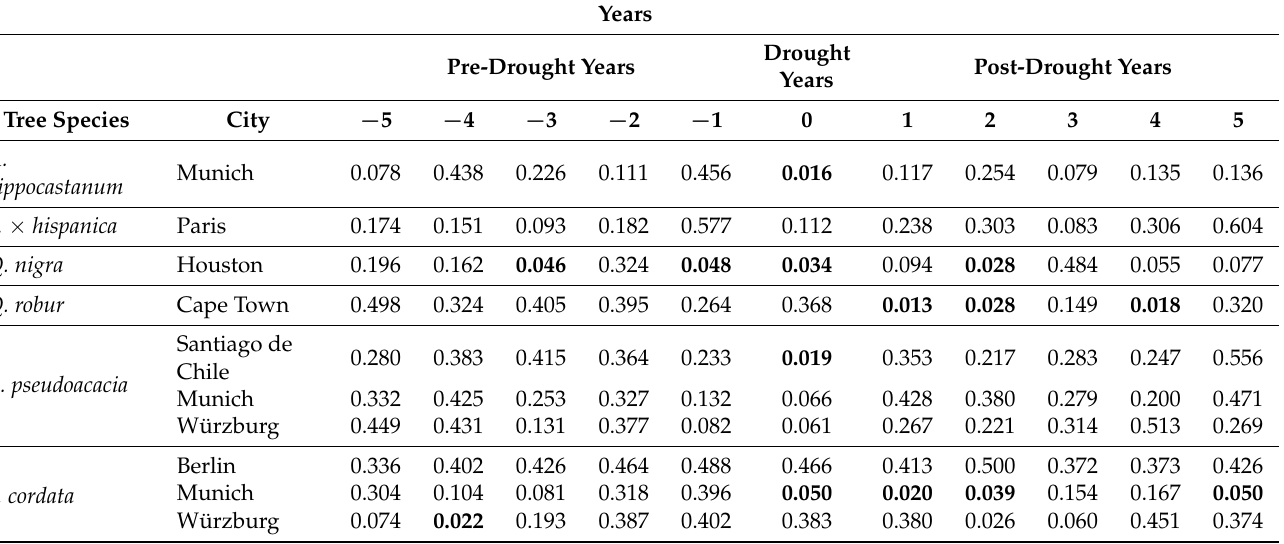
Table A3. Superposed epoch analysis (SEA) for the single urban tree species in seven cities. p values are listed for the pre-drought years ( − 5 to − 1), the drought years (0), and the post-drought years (1–5). Significant p values ( p < 0.05) are printed in